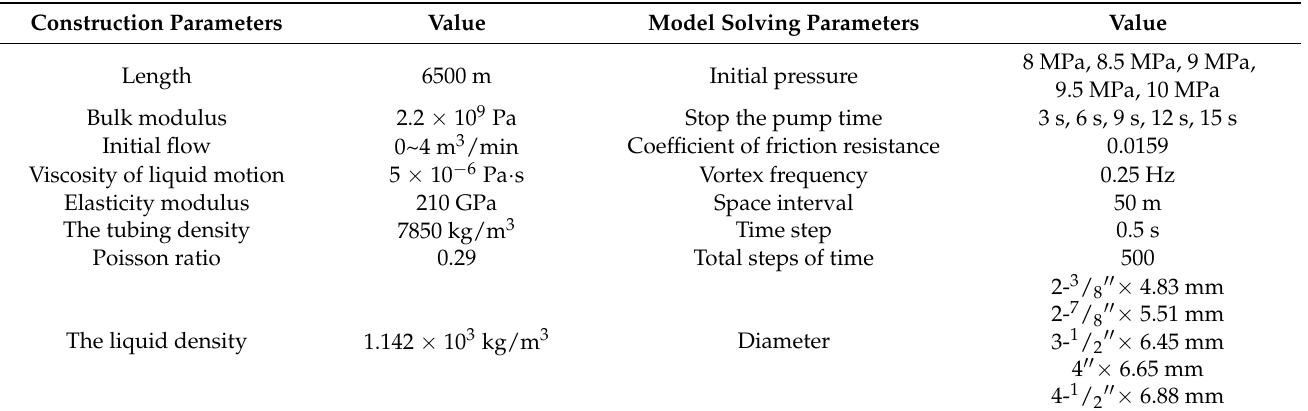
Table 1. Values of tubing vibration